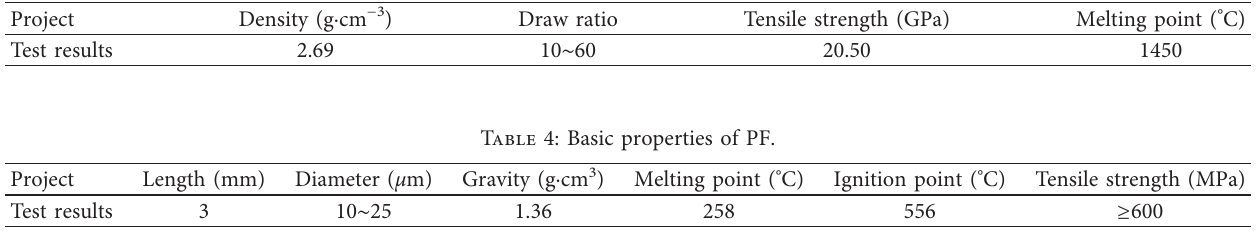
Table 3: The basic properties of CSW.